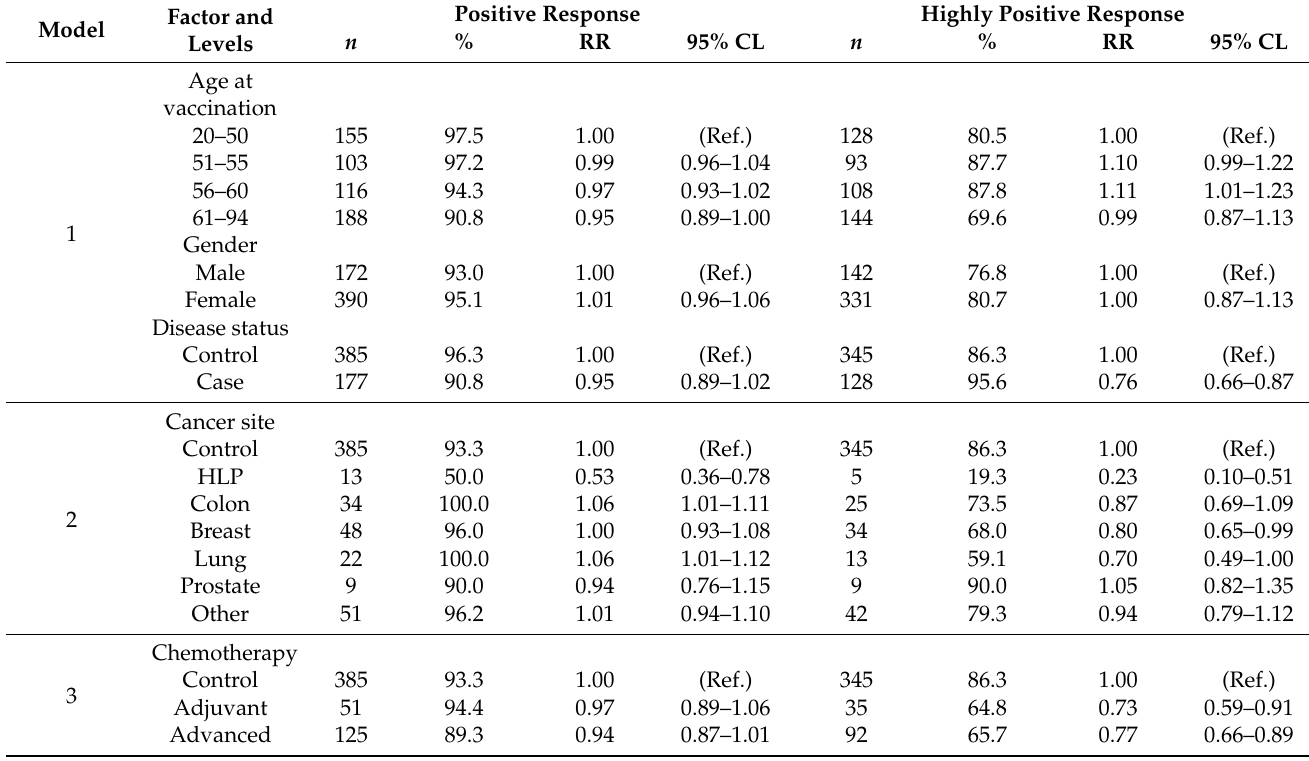
Table 3. Joint effect of individual characteristics on a positive (IgG > 4.33 BAU/mL) or highly